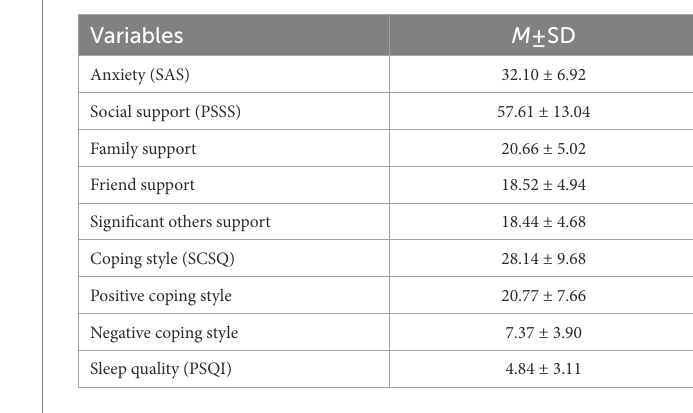
TABLE 2 Descriptive scores of